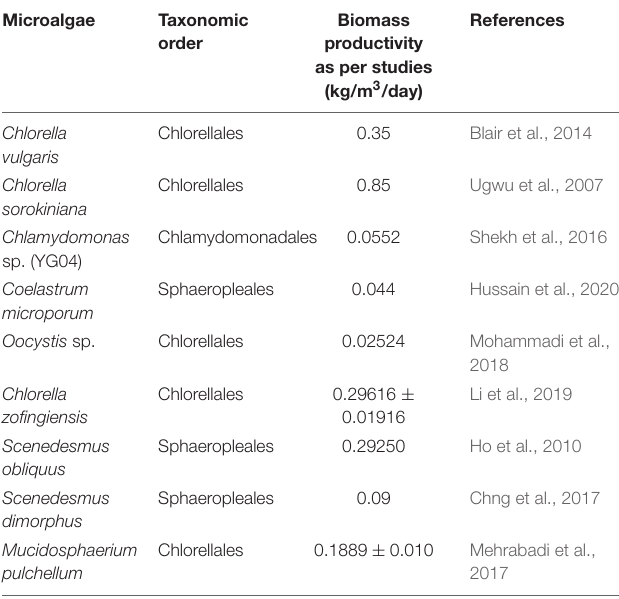
TABLE 2 | Showing the rate at which different microalgal species grow by assimilating nutrients into their biomass under specific condition sets. Microalgae Taxonomic Biomass order productivity as per studies (kg/m 3